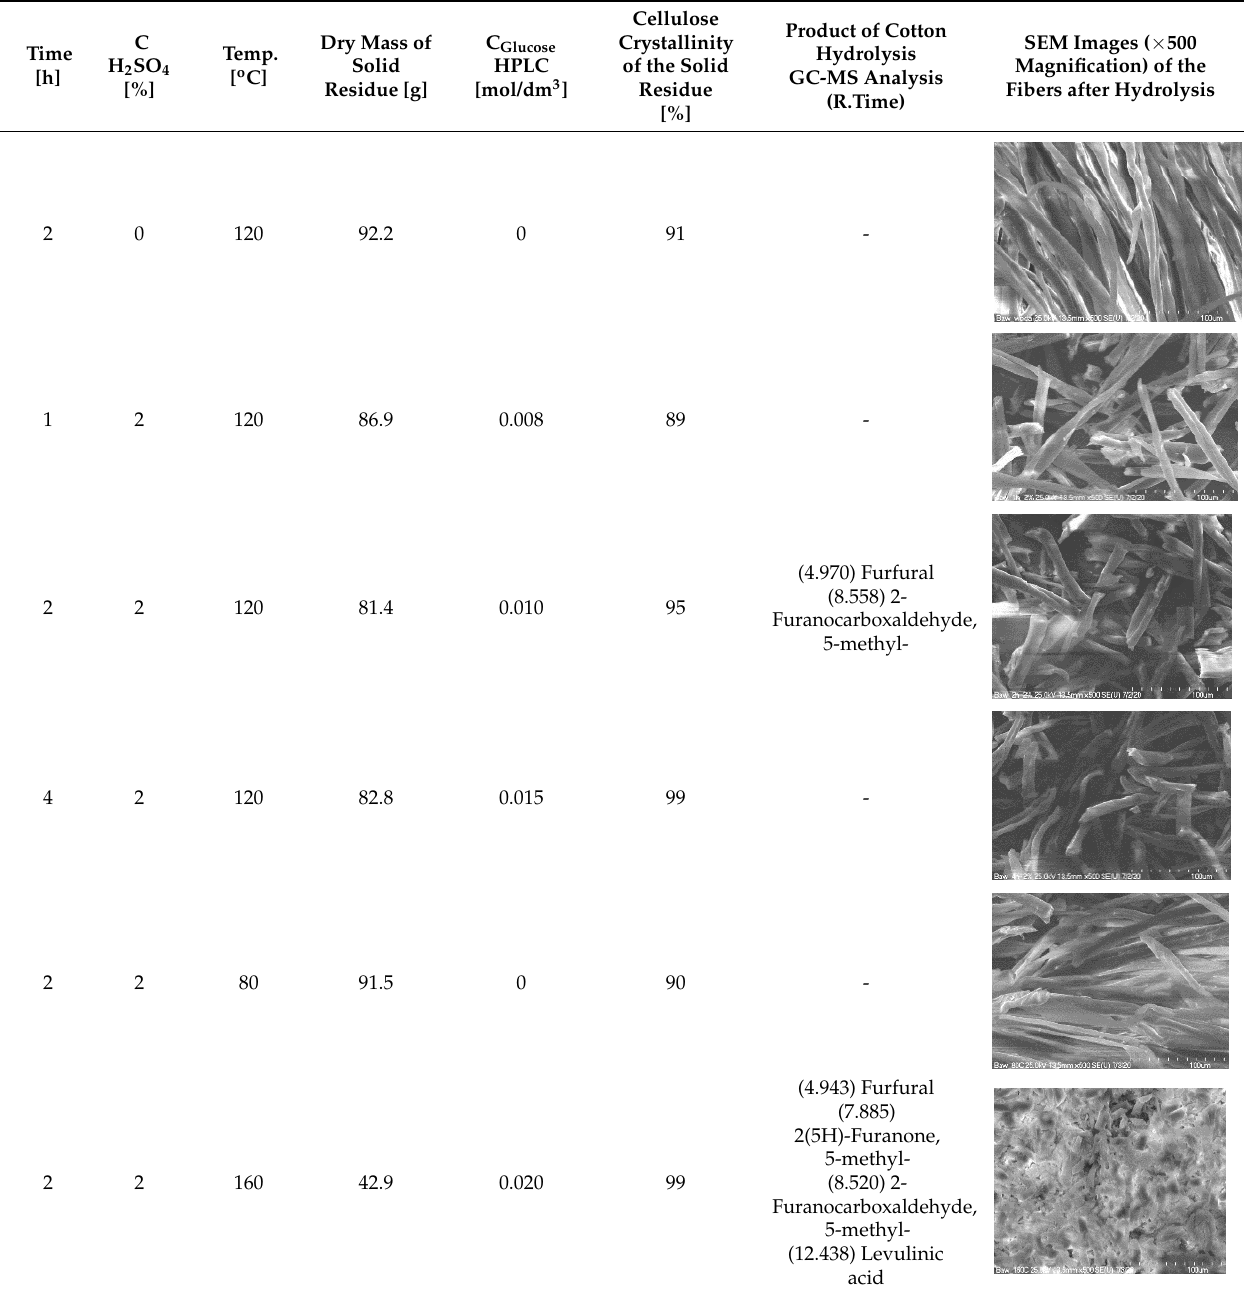
Table 5. Acidic hydrolysis of cotton fiber. In each process, 100 g of comminuted cotton yarn (>0.5 cm long) and 2 dm 3 of the solution of H 2 SO 4 (concentration 2–10%) were used. The process was carried out between 1 and 4 h in a temperature range of 80–160 ° C.